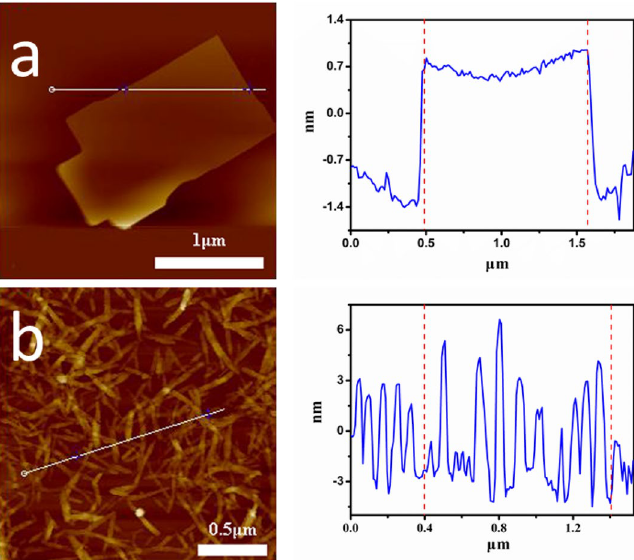
Figure 1. ( a ) Size of GO nanosheets, and ( b ) rod-like